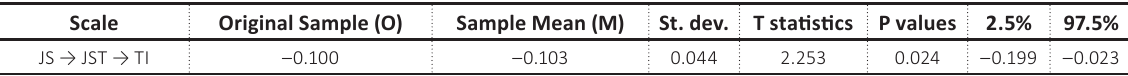
Table 6. Indirect effects